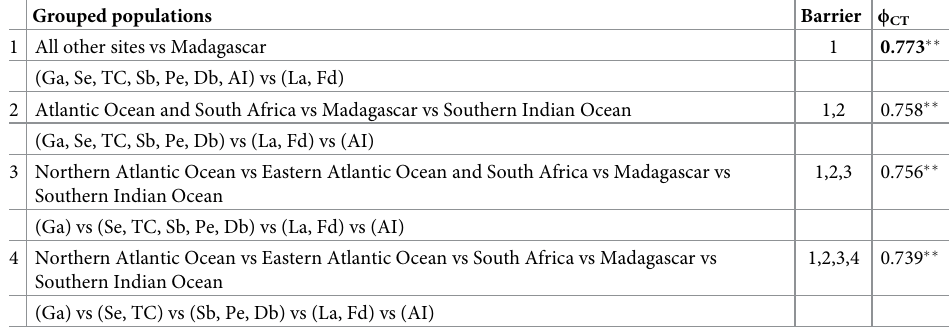
1,2,3 0.756 �� 1,2,3,4 0.739 ��